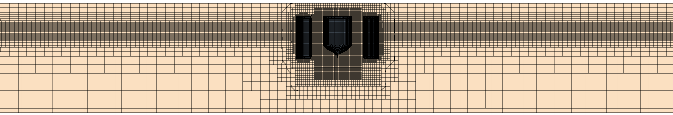
Figure 4. Grid around the MJWEC mode.